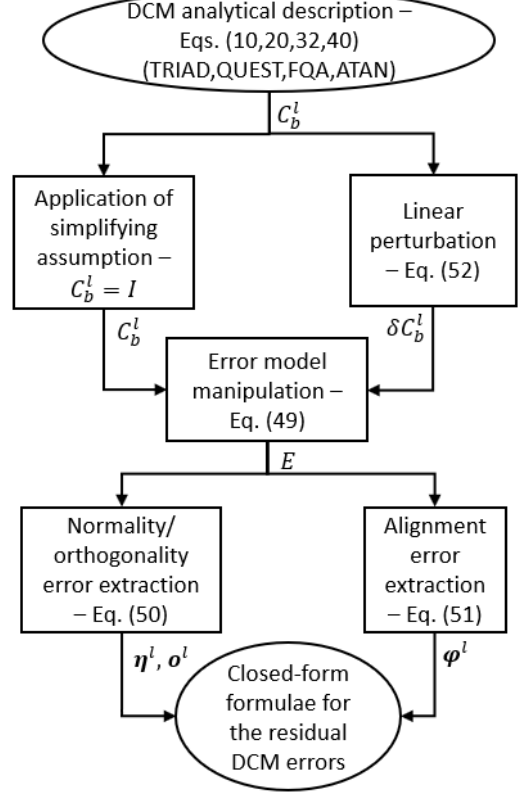
Figure 1. Summary of the closed-form formulae derivation